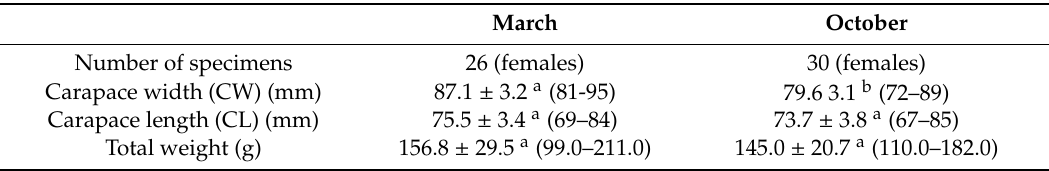
Table 1. Biometric data of C. maritae caught in March and October (average ± standard deviation, values between brackets are minimum and maximum values of each measurement).